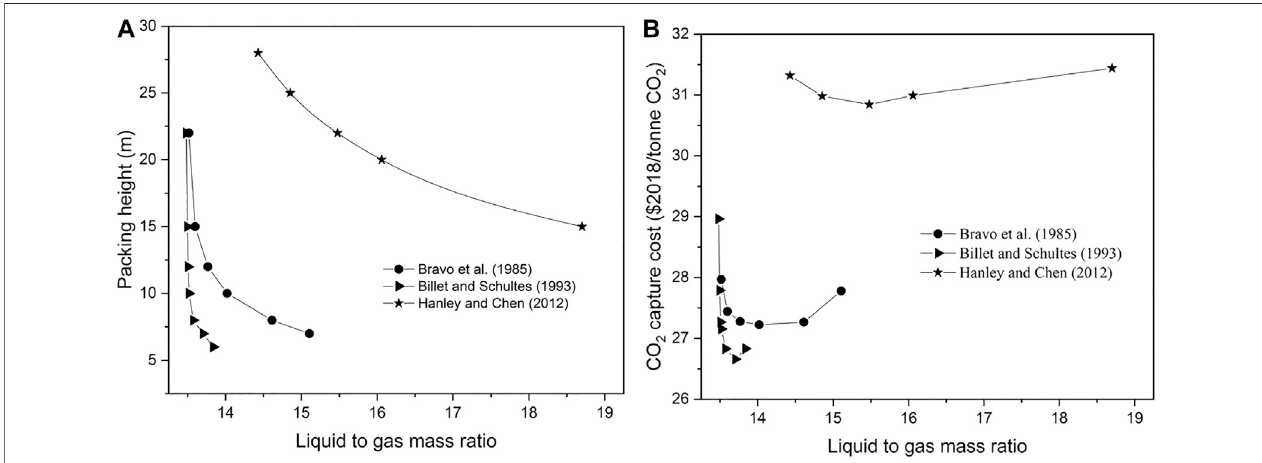
FIGURE 2 | CO 2 capture cost at different liquid to gas ratios with different rate-based model (left: packing height-L/G ratio, right: CO 2 capture cost-L/G ratio).